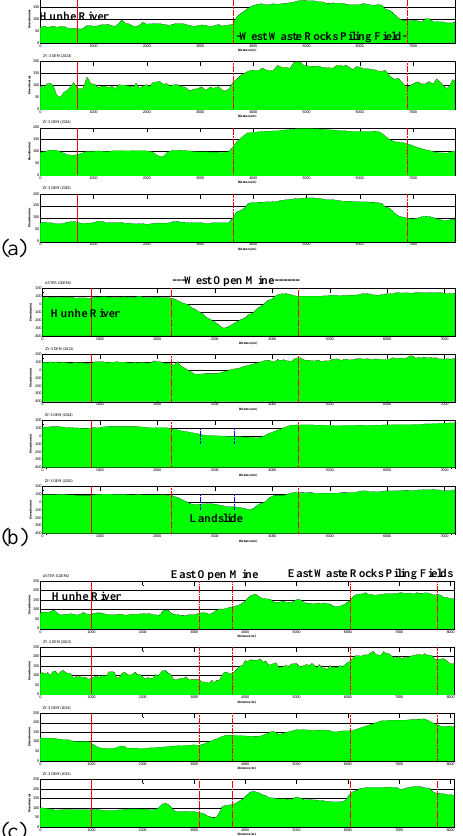
Figure 8 Topographic profiles derived from ASTER GDEM, ZY-3 DEM 2013, 2014, 2015 respectively. (a) Profile 1. (b) Profile 2. (c) Profile